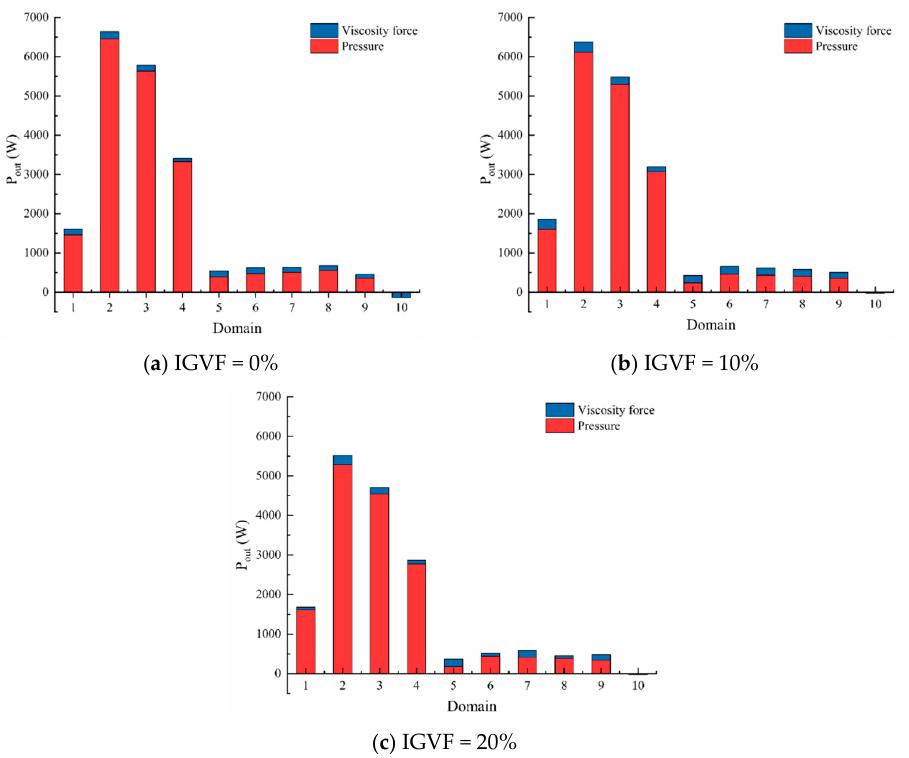
Figure 11. The distribution of the output power within each fluid domain under different IGVFs at the serious cavitation stage.